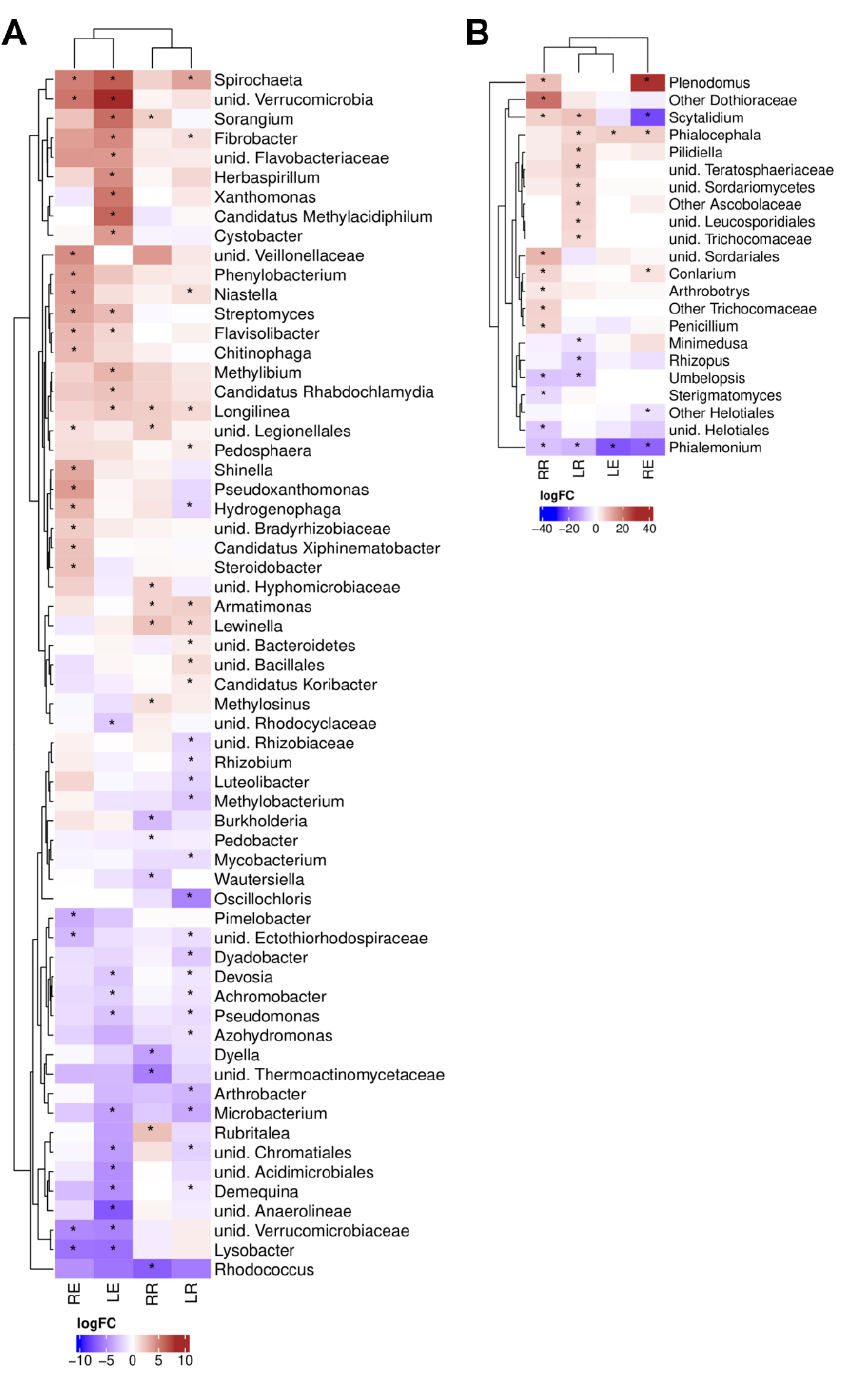
Figure 4. Bacterial ( A ) and fungal ( B ) heatmap of differentially abundant taxa present in the rhizosphere (LR) and endorhizosphere (LE) samples of the leaf-inoculated seedlings and in the rhizosphere (RR) and endorhizosphere (RE) samples of root-inoculated seedlings. Differentially abundant taxa were evaluated among the most significative samples (* indicates p < 0.05). Each cell depicts the log 2 fold change (logFC) of each microbial taxon and is colored according to depleted (blue), not differentiated (white), and enriched (red) conditions.